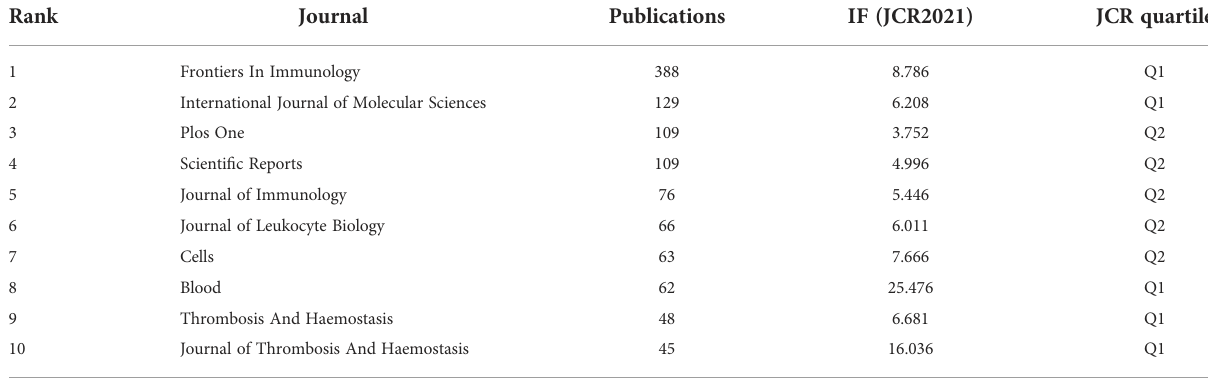
TABLE 4 Top 10 journals in terms of number of publications, corresponding IF (JCR 2021) and JCR quartile.